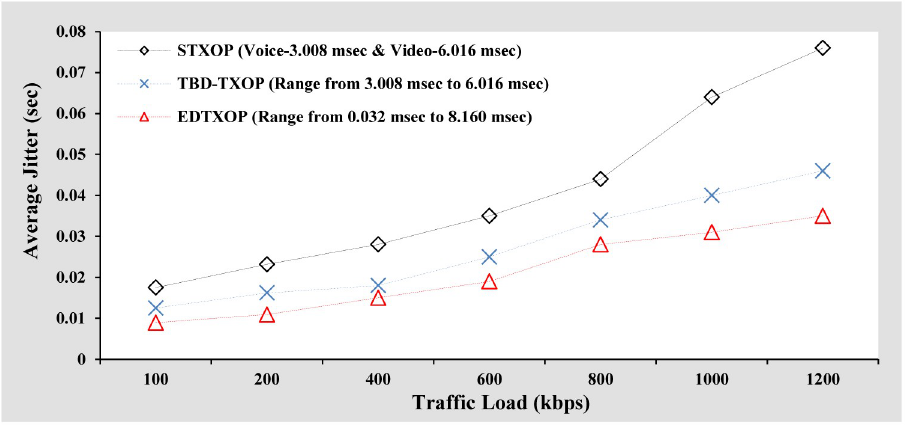
Fig 11. Average jitter analysis based on increasing packets arrival